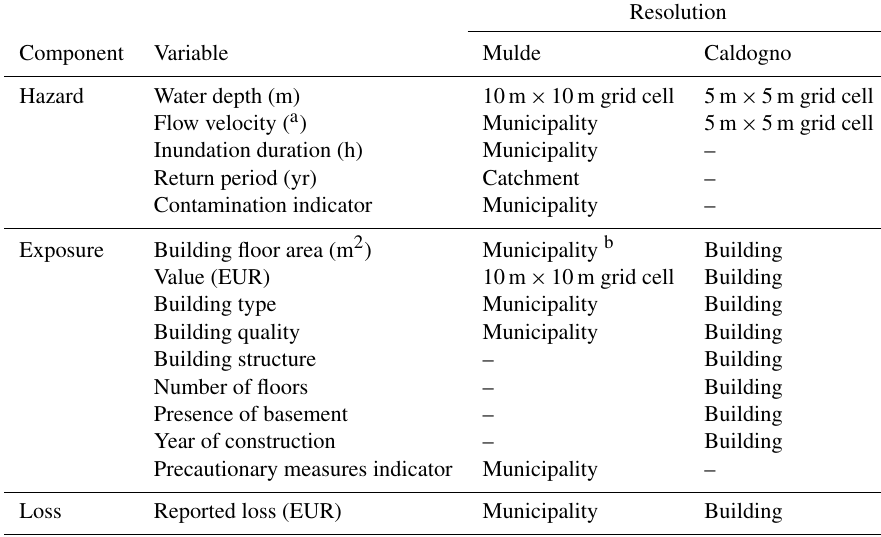
Table 2. Input variables for the Mulde and Caldogno application cases.